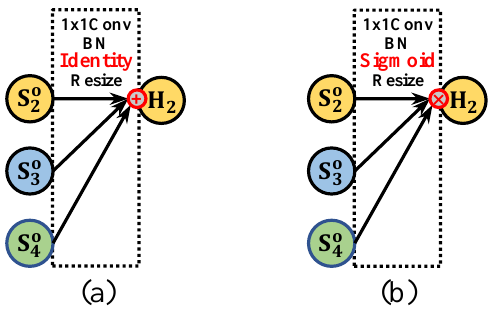
Figure 5. FSHead vs. MEMe-based FAHead. ( a ) Final sum head. ( b ) The mutually enhanced final attention head. The FAHead’s output is mutually enhanced by the Sigmoid and point-wise multiplication to query and calibrate each other, which is a simple but solid way of